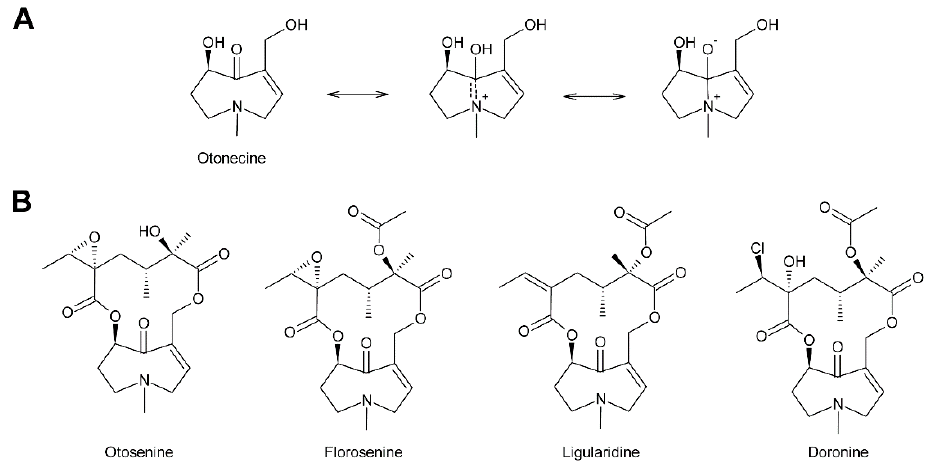
Figure 3. Otonecine and representative PAs. ( A ) Resonance structures of otonecine. ( B ) Structures of